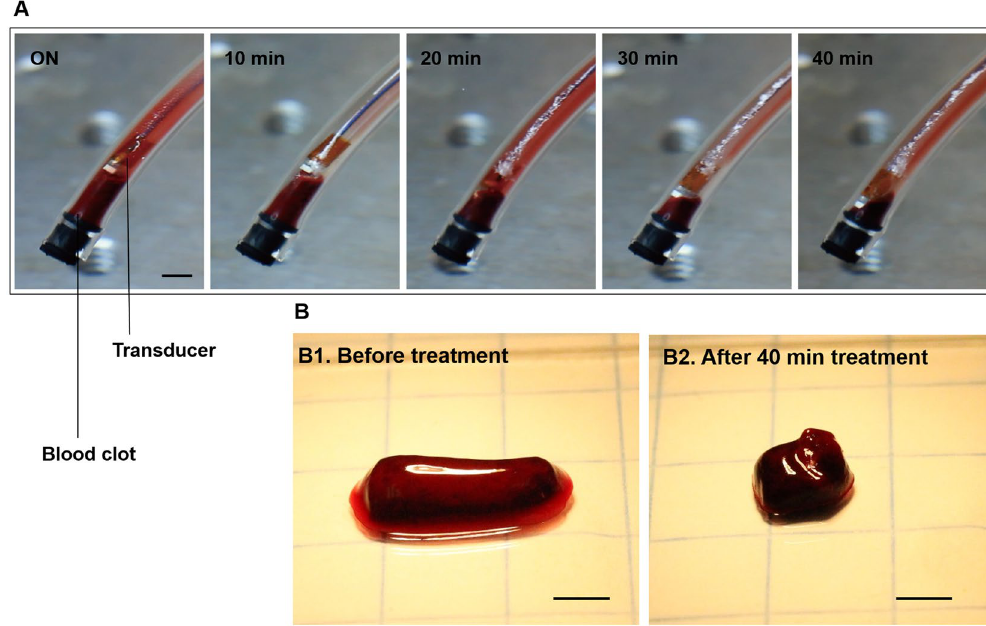
Figure 3. In vitro clot lysis by microbubble-mediated intravascular ultrasound. ( A ) Captured images during 40 min treatment by using the planar-aperture prototype (input conditions of 620 kHz, 80 V pp , 10% duty